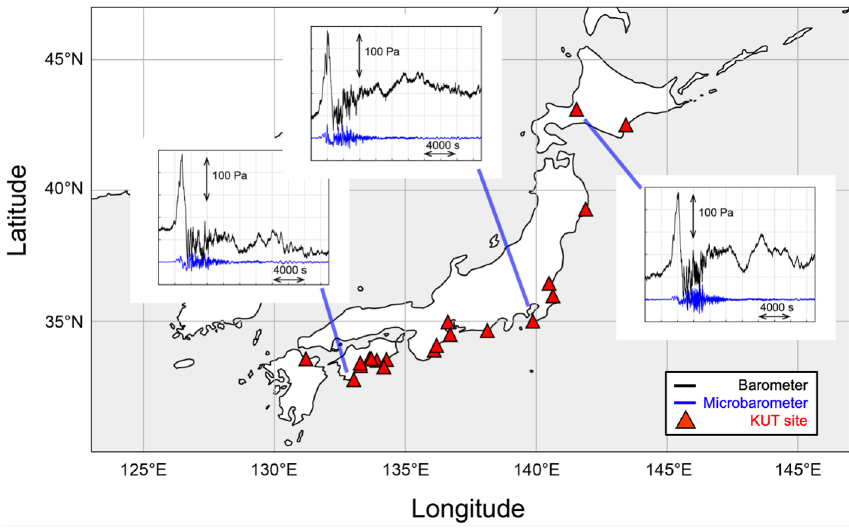
Figure 1. Location of Kochi University of Technology (KUT) infrasound sensors and their observed data after the Tonga volcanic eruption. The KUT installed more than 30 infrasound sensors to form a Japan-wide infrasound observation network. Every site has a SAYA INF01-type comprehensive sensor that contains a membrane-type infrasound sensor, a barometer, a thermometer, and a three-component accelerometer of small MEMS sensor chips. These observation sites are 7700 to 8400 km away from Tonga volcano, and the pressure fluctuations were monitored approximately 7 hours after the eruption. Examples of time series of pressure perturbation are shown; the observed signals had similar waveforms regardless of their locations. The map is created with Matlab R2022B (www. mathw orks.